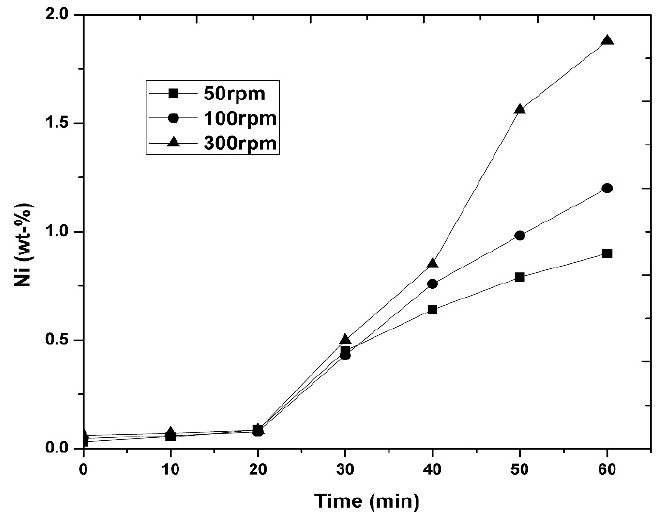
Figure 4. Increase in the nickel concentration as a function of injection time, at the indicated agitation speeds, for an initial Mg concentration of 3 wt-%, and a temperature of 1123 K.